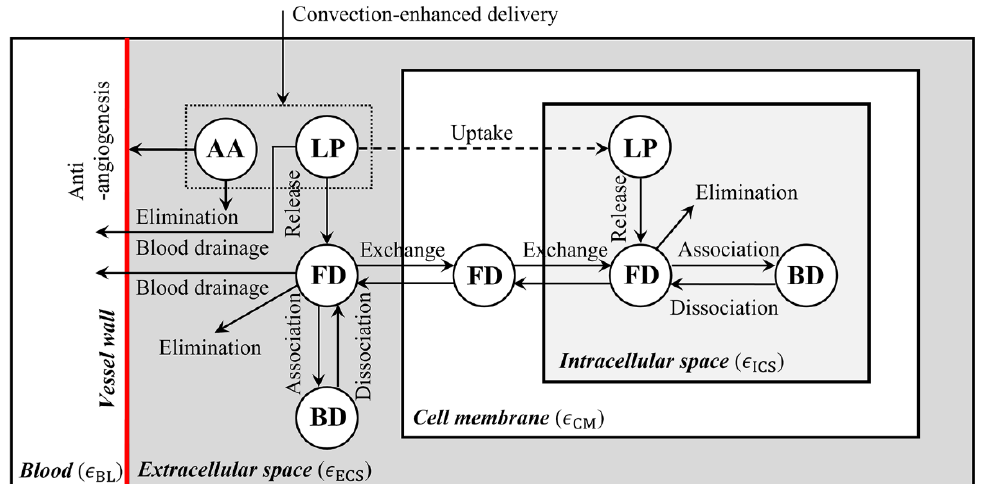
Figure 1. Drug transport in brain tumor after infusion. Liposomal cytotoxic drugs and antiangiogenic drugs are infused into the tumor ECS simultaneously. The released free cytotoxic drugs can cross the cell member to enter the cell interior; whereas liposome cell uptake strongly depends on the formulation, morphology and surrounding environment. As a result, some types of liposomes can enter cells efficiently, while others cannot cross the cell membrane. Therefore, this process is marked in a dashed line. Since there is a lack of a general model to govern this highly liposome-specific process due to its complexity, liposome cell uptake was ignored in several past studies [15,37]. AA — antiangiogenic drugs, LP — liposome-encapsulated cytotoxic drugs, FD — free cytotoxic drugs, and BD — cytotoxic drugs that bind with proteins.